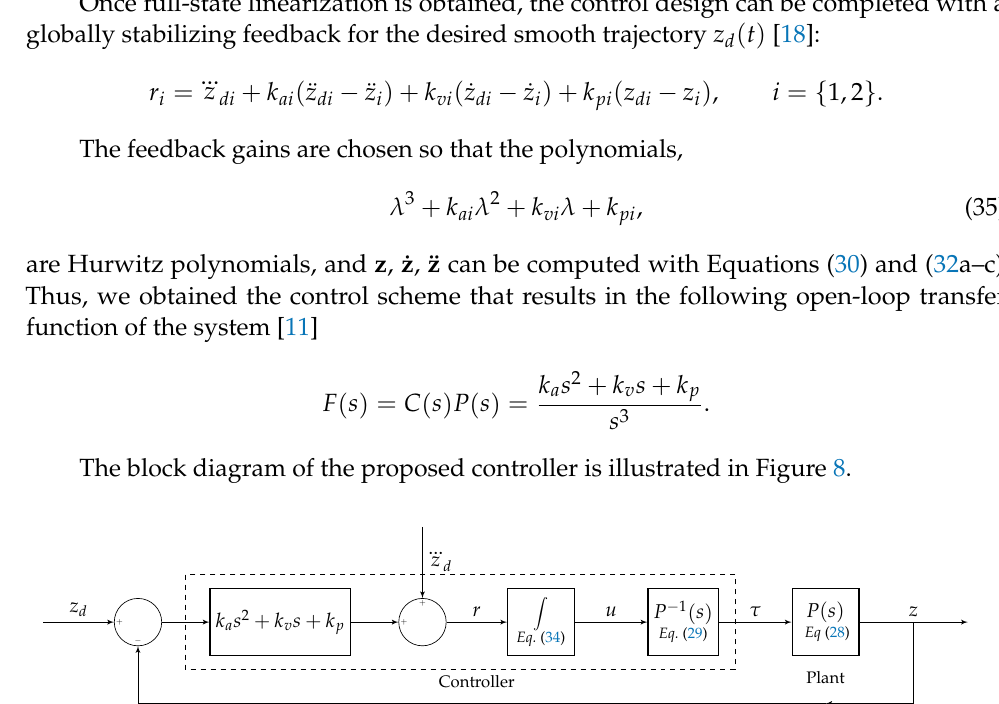
Figure 8. Block diagram of the trajectory tracking control